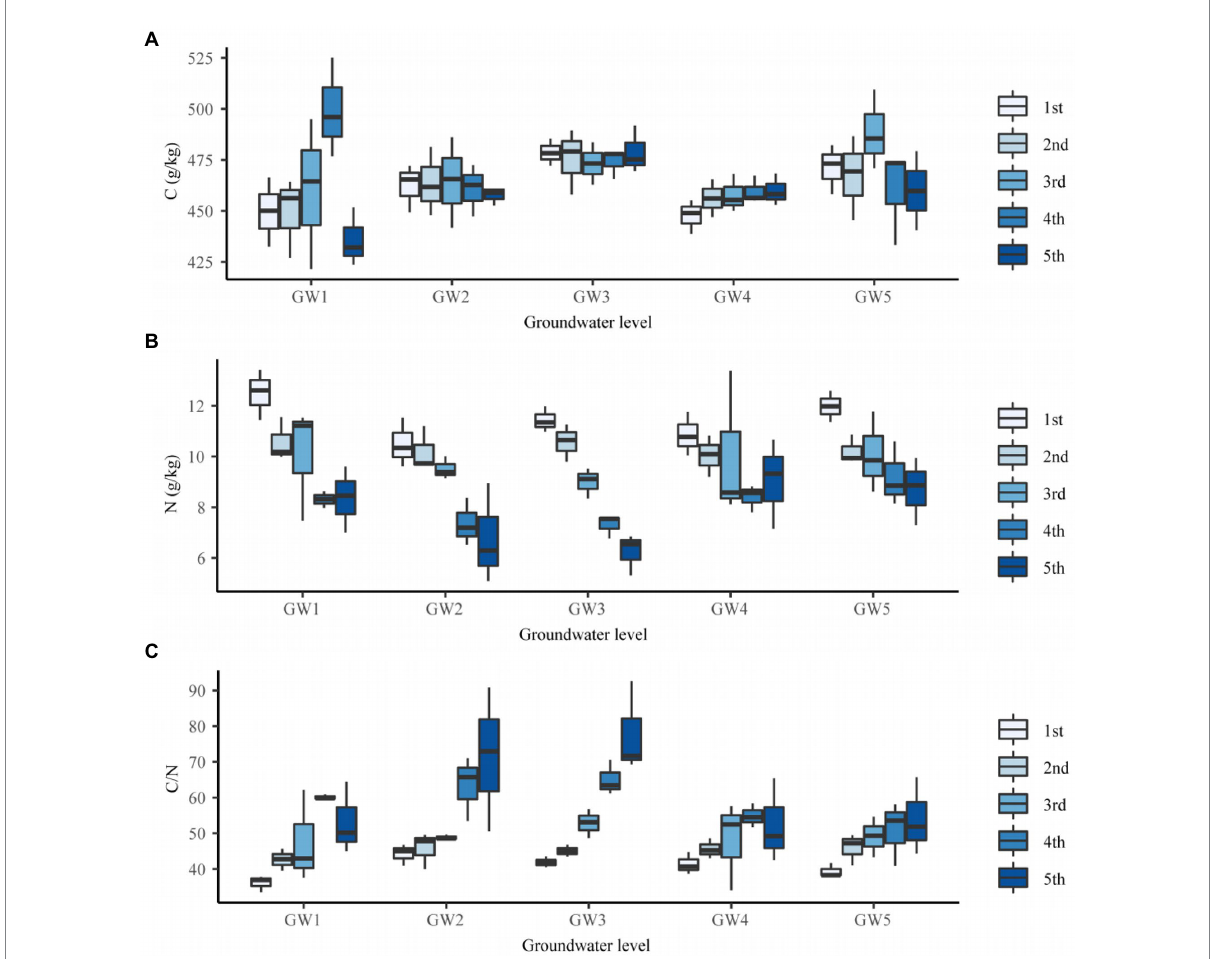
FIGURE 3 The C content (A) , N content (B) , and C/N (C) of fine roots of different orders of Tamarix chinensis at different groundwater